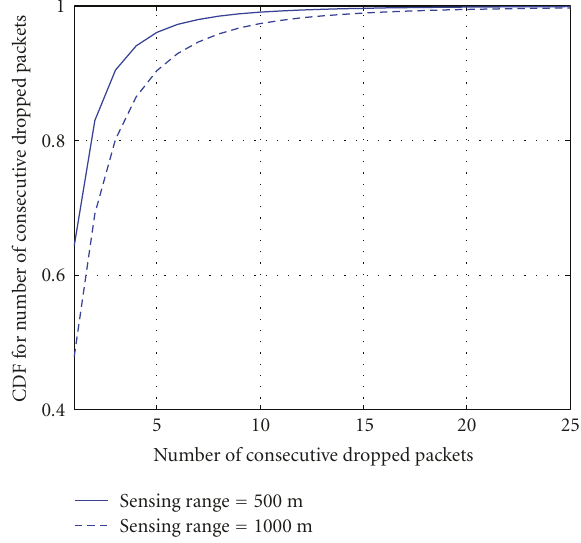
Figure 6: Number of consecutive dropped packets due to no channel access.